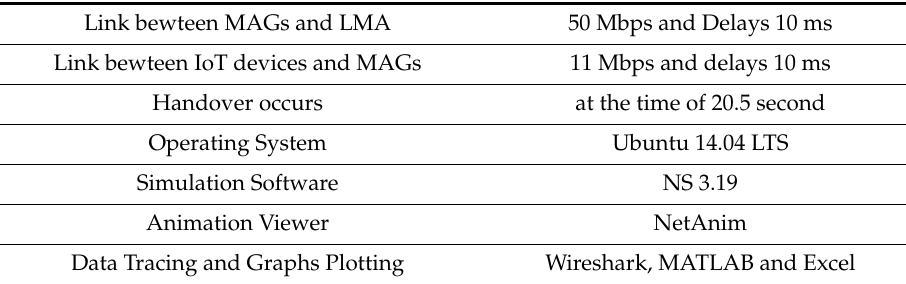
Figure 7. NetAnim view of PB-PMIP for IoT. Table 1. Simulation parameters.